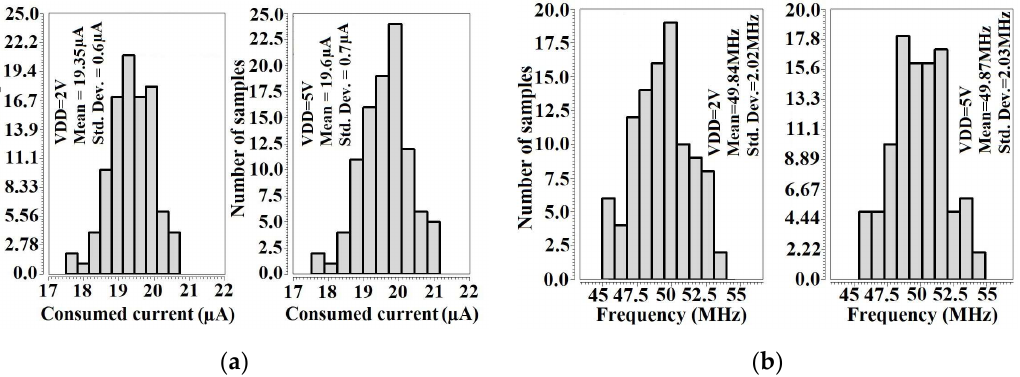
Figure 10. Monte Carlo simulations histograms. ( a ) Oscillation frequency; ( b ) ring oscillator con- sumed current.